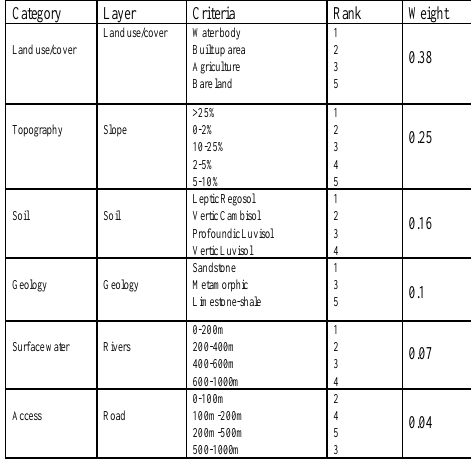
Table 1: Attribute scores and weights for the maps used in the waste disposal site